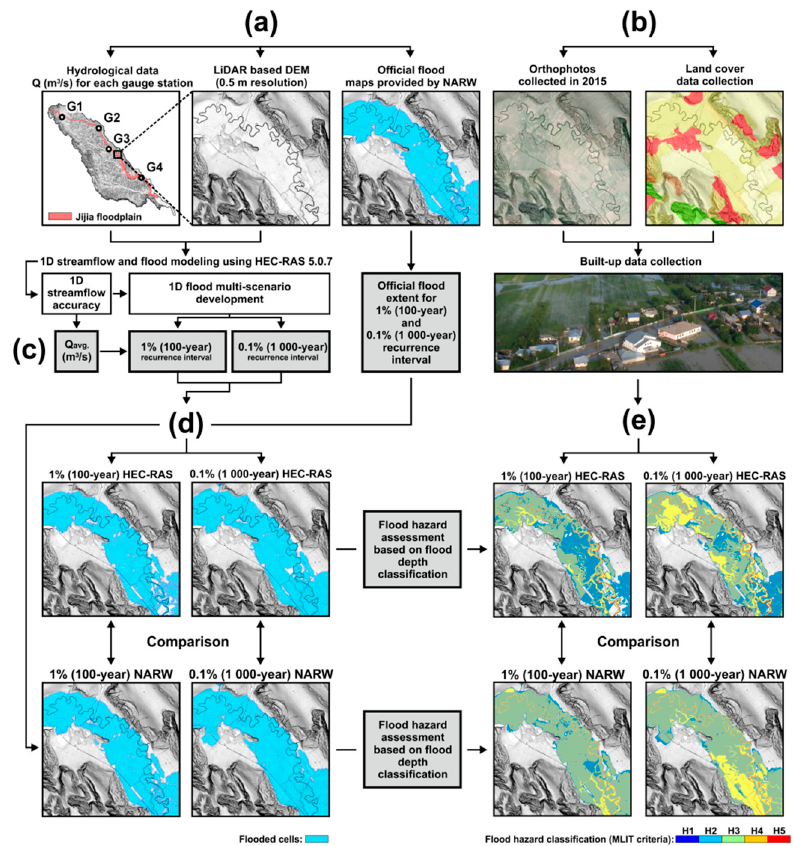
Figure 3. Workflow chart followed in this study: ( a ) obtaining the hydrological data recorded at each gauge station within the Jijia floodplain (G1, G2, G3, and G4), LiDAR based DEM (0.5 m spatial resolution) data, and the official flood hazard maps with 1% (100-year) and 0.1% (1000-year) recurrence interval probabilities used for 1D HEC-RAS modeling process and flood hazard comparison; ( b ) manual digitization of land cover classes and built-up areas using high resolution orthophotos for flood hazard assessment; ( c ) 1D HEC-RAS multi-scenario development with 1% (100-year) and 0.1% (1000-year) recurrence interval probabilities, where Q avg was generated based on average discharge for 1D stream flow accuracy; ( d ) comparison between 1D HEC-RAS flood extents and official flood extents provided by NARW with 1% (100-year) and 0.1% (1000-year) recurrence interval probabilities; ( e ) flood hazard assessment based on the built-up data and flood depth classification according to the MILT and comparison between 1D HEC-RAS hazard models and official flood hazard maps with 1% (100-year) and 0.1% (1000-year) recurrence interval probabilities.